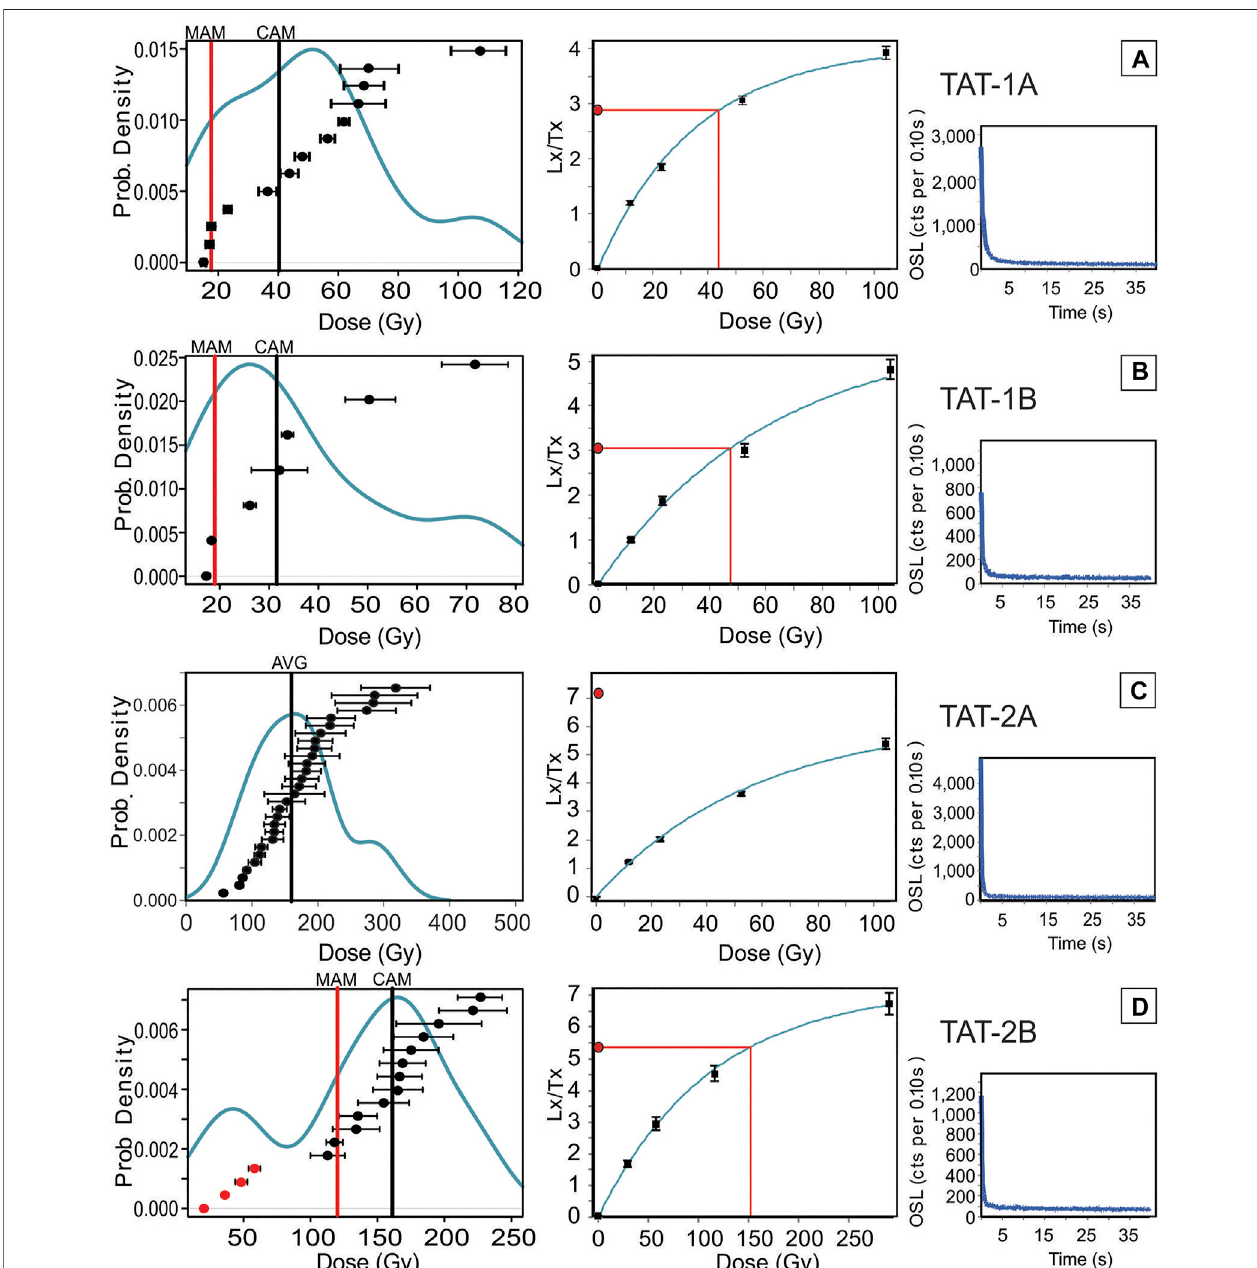
FIGURE3| OSLdataofthesamples: (A) TAT1A; (B) TAT1B; (C) TAT2A;and (D) TAT2B.Graphsontheleftshowequivalentdose(D e )distributions forthedated samples,exceptfor (C) ,wherethe2D 0 distributionisshown;atthecenterthedose-response curvesforarepresentativequartzaliquotineach sample;andontheright, the natural OSL decay curve. The red circles in (D) are outliers aliquots. MAM is the Minimum Age Model and CAM is the Central Age Model; in (C) , the average (AVG) is shown for the 2D 0